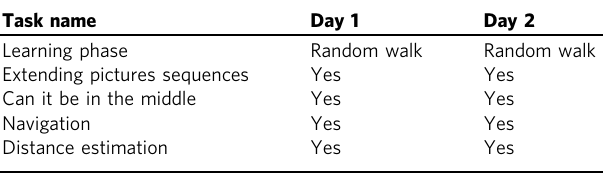
Table 2 Transferring of community